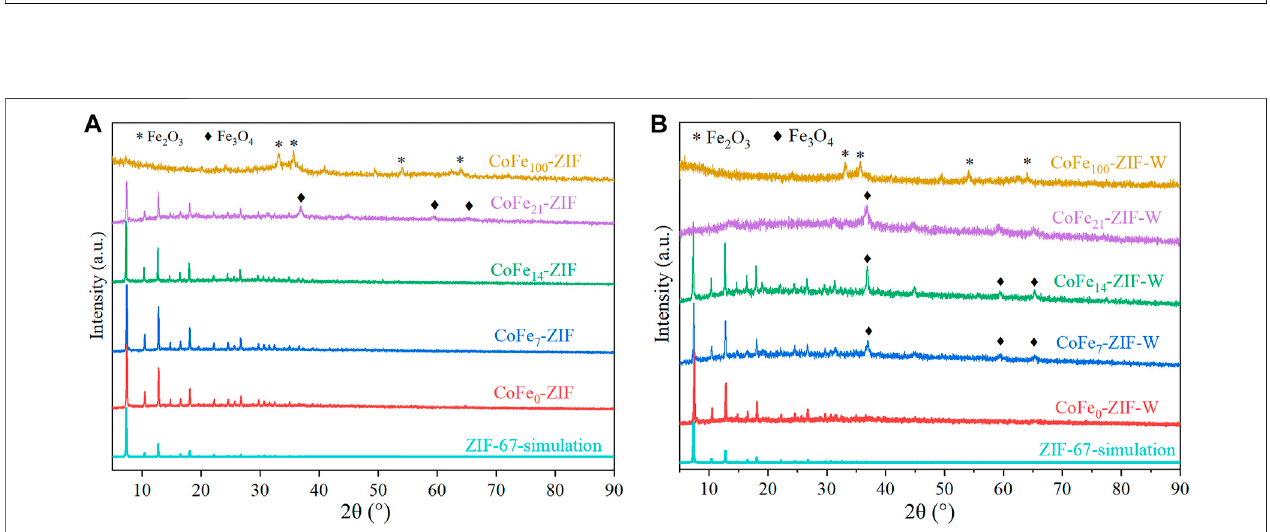
FIGURE 2 | XRD patterns of catalysts under different preparation conditions (A) thermo dissolution method (B) microwave dissolution method.